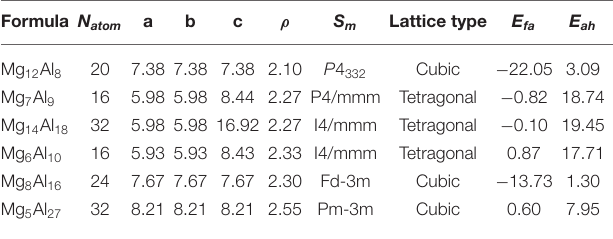
TABLE 1 | Lattice parameters a(Å), b(Å), c(Å), density ρ (g/cm 3 ), space group symbol S m , lattice type, formation energy E fa (meV/atom), and energy above the convex hull E abh (meV/atom) of Mg 12 Al 8 , Mg 7 Al 9 , Mg 14 Al 18 , Mg 6 Al 10 , Mg 8 Al 16 , and Mg 5 Al 27 calculated by